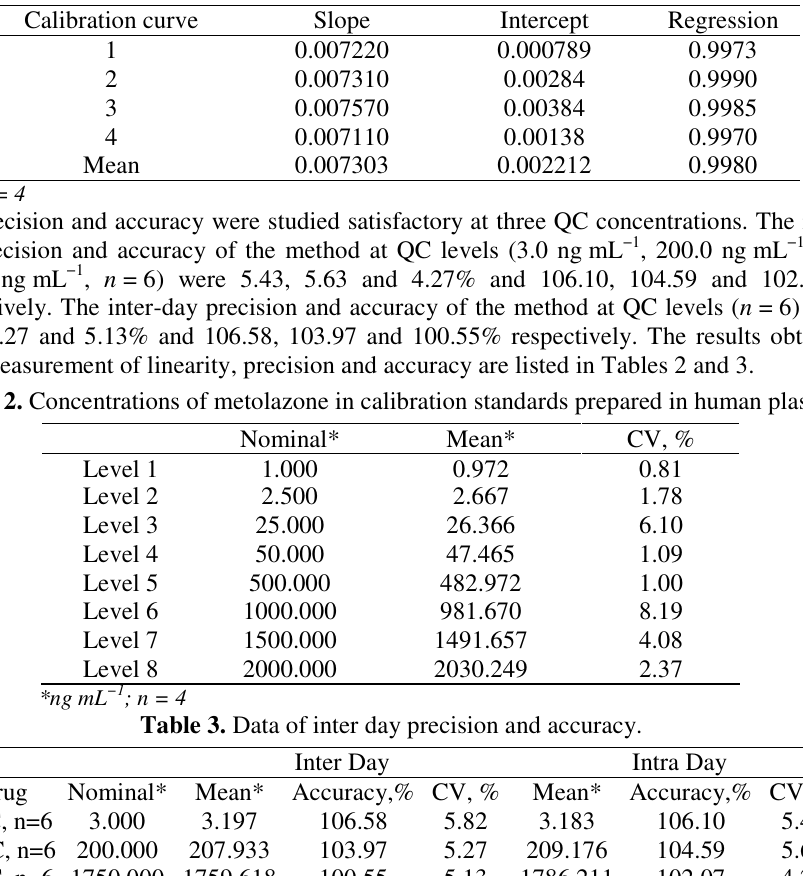
Table 1. correlation coefficient (r)